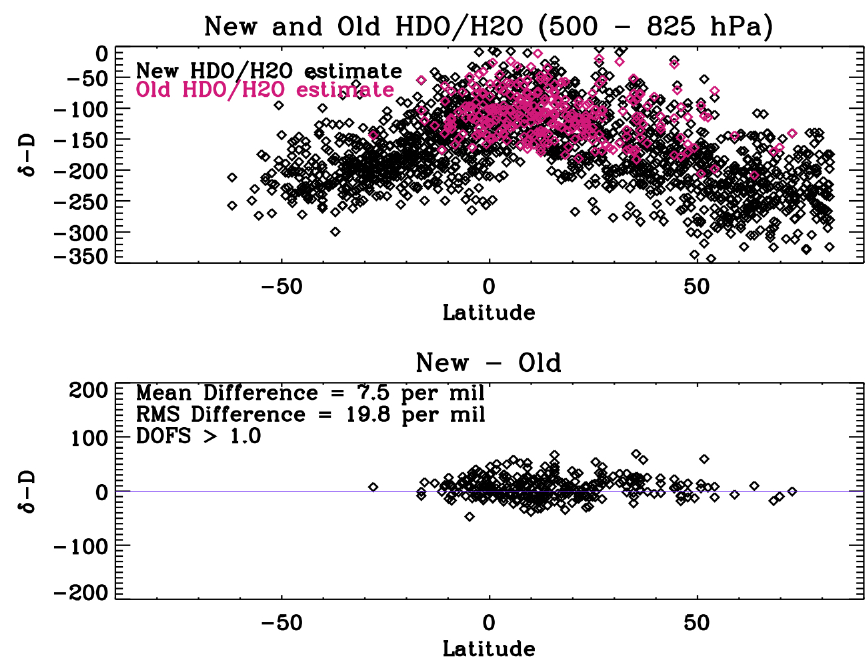
Figure 5: (top) Comparison of the new and old (Version 6) HDO/ H Fig. 5. (top) Comparison of the new and old (Version 6) HDO/H 2 O estimates. A DOFS threshold of 1.0 is used for the data in the top DOFS threshold of 1.0 is used for the data in the top panel for both releases. panel for both releases. (bottom) Difference between old and new HDO/H 2 O estimates for the overlapping data shown in the top panel. (bottom) Difference between old and new HDO/ H δ − D =1000(HDO/H 2 O/3.11 × 10 − 4 − data shown in the top panel. δ -­‐D = 1000(HDO/ H